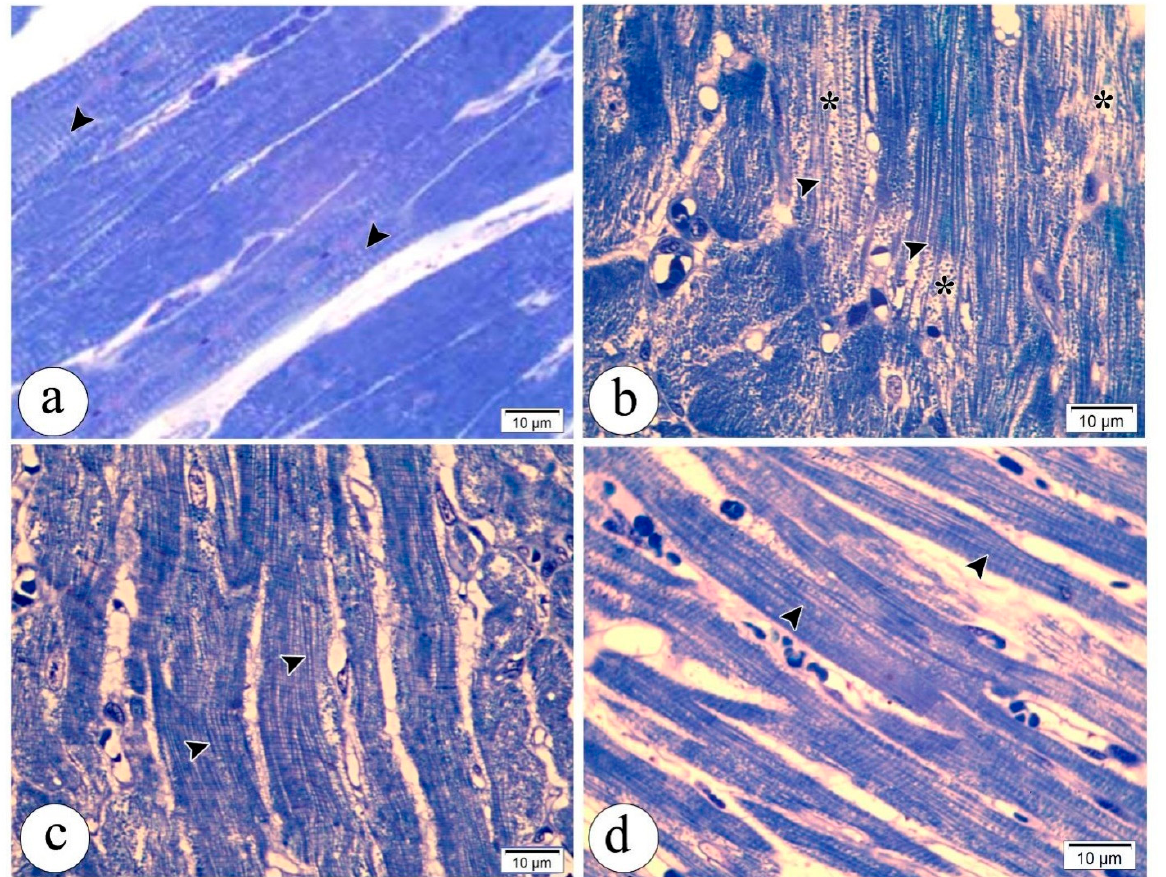
Figure 5. Semithin sections of cardiac muscles showing transverse striations: ( a ) Control group showing cylindrical cardiac muscle fibers and central, oval, and vesicular nuclei, along with visible transverse striations (head arrow); ( b ) gentamycin-treated group showing loss of striation in some parts of the cardiomyocytes( head arrow), along with areas of fibrinolysis (star); ( c ) gentamycin- and PUFA-treated group showing restored normal striation of cardiac muscle fibers but less prominent striations compared with the control group (head arrow); ( d ) gentamycin- and MSC-treated group showing more or less normal cardiac muscle fibers with visible transverse striations (head arrow).